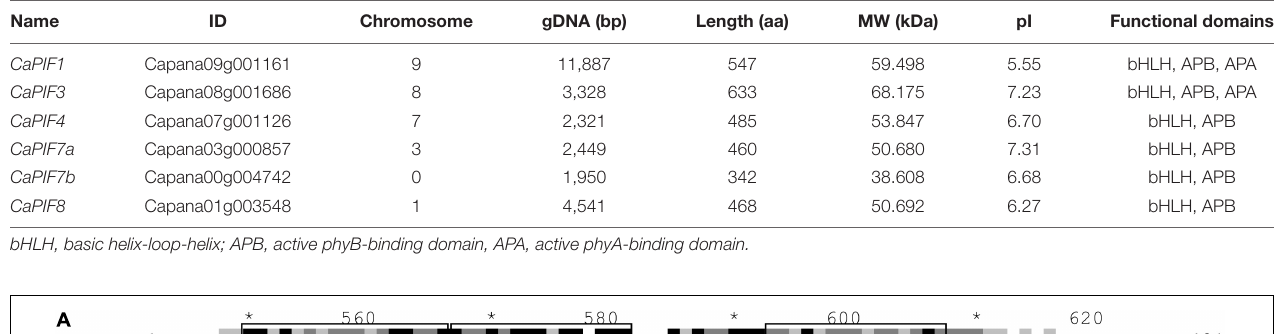
TABLE 1 | Characteristics of phytochrome-interacting factor ( PIF ) genes in pepper.